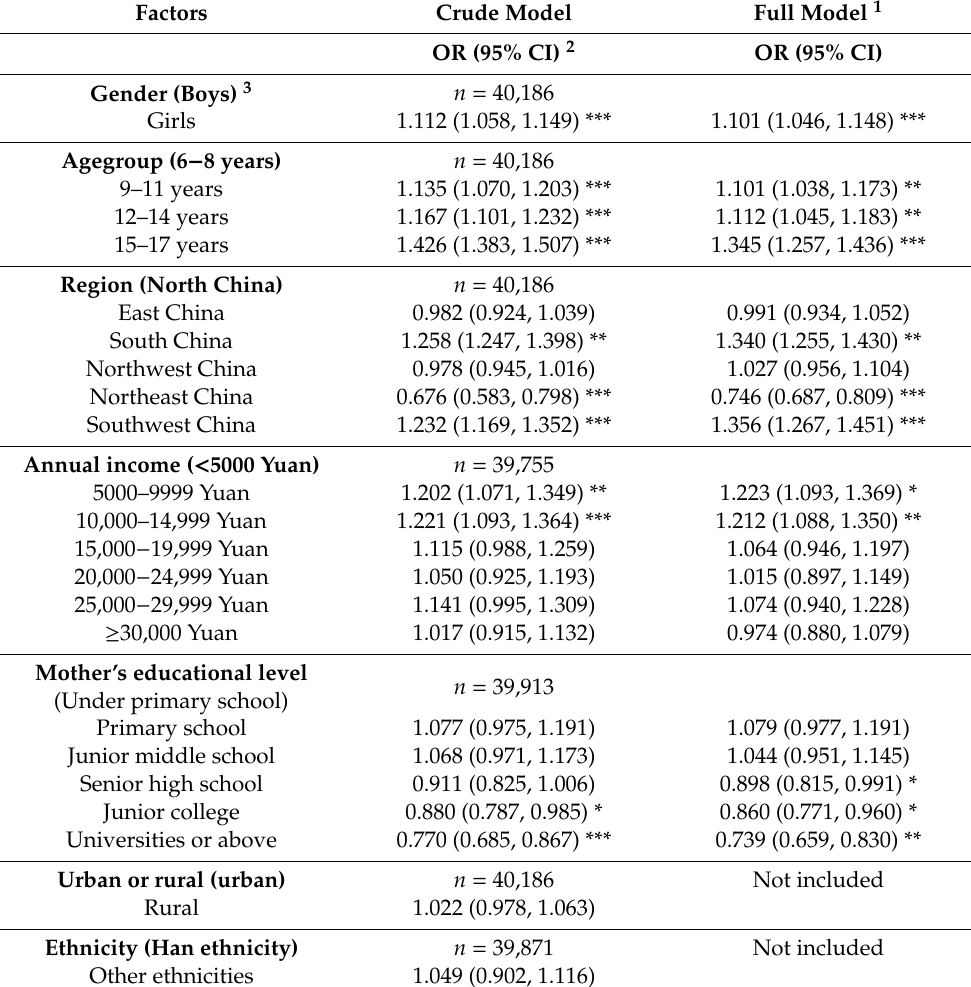
Table 3. E ff ects of socio-demographic factors on children’s exposure to